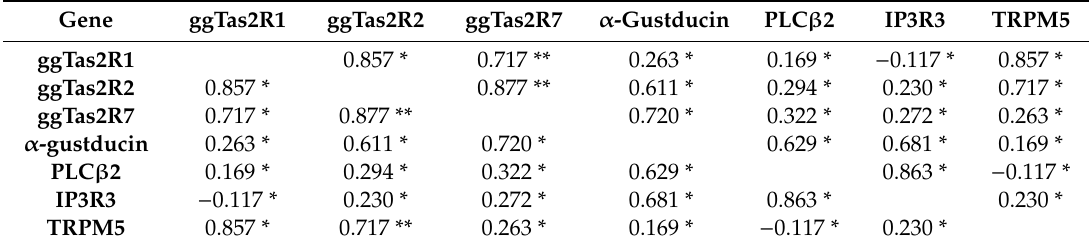
Table 3. Correlation analysis of bitter taste and downstream signaling e ff ectors related-genes in the kidney of